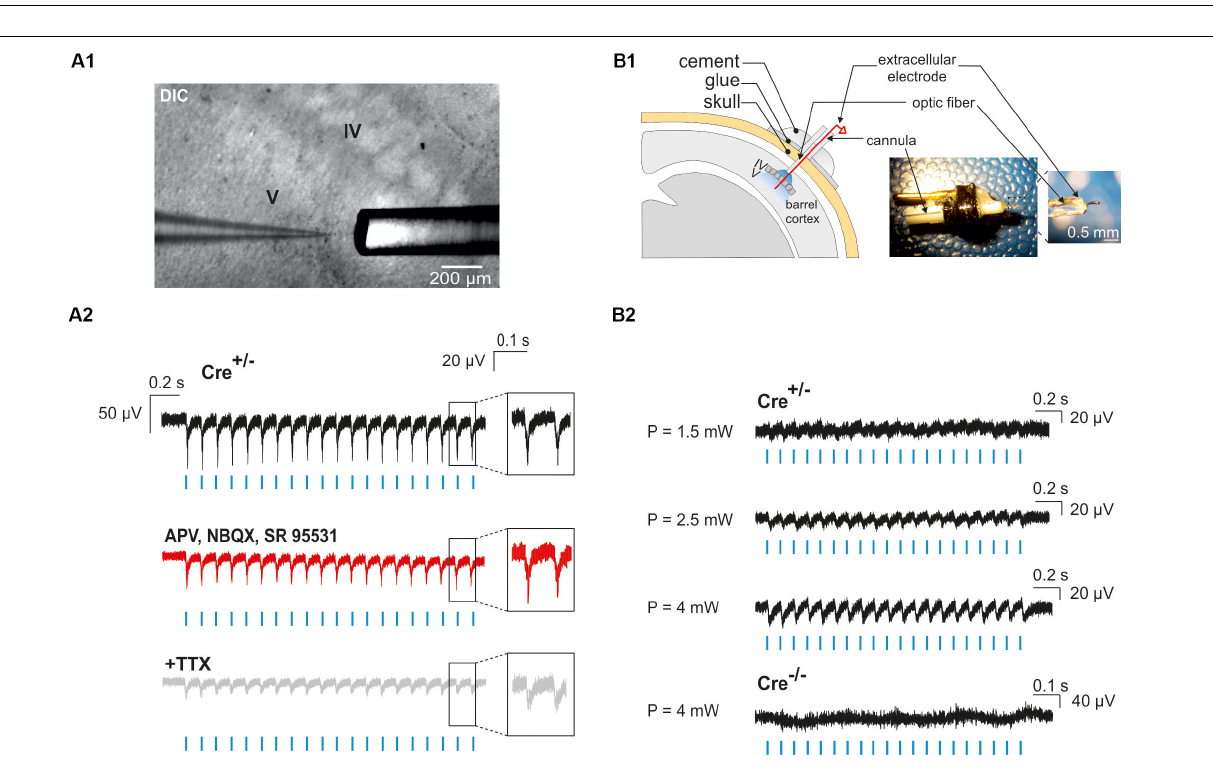
FIGURE 5 | Photo-evoked LFPs in PN10 mouse pups in brain slices and in vivo . (A) Extracellular recordings were performed in the cortical layer V of brain slices during photostimulation with an optic fiber located just above the recording site (A1) . LFPs evoked by photostimulation ( A2 , blue lines) were faithfully reproduced in response to every light pulse (black trace, inset) in ChR2-expressing transgenic mice (Cre + / − ). Recording of the same slice during bath application of glutamatergic and GABAergic antagonists (50 µ M APV, 10 µ M NBQX, 10 µ M SR95531; A2 red trace) and TTX (1 µ M, A2 gray trace) are shown. DIC: Differential interference contrast image. (B) In vivo extracellular recordings of cortical layer V were performed by the placement of a custom-made optrode containing a mini-optic fiber and a 50 µ m Ni/Ag wire (B1) . In vivo LFPs were successfully evoked by photostimulation ( B2 , blue lines) above 1.5 mW of light power in a ChR2-expressing transgenic mouse (Cre + / − ). The reported powers from 1.5 to 4 mW correspond to the power per pulse estimated from measurements in continuous wave (CW) mode. No responses were evoked in a Cre − / − control